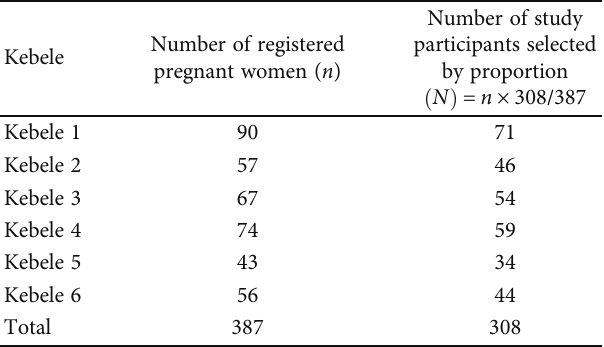
Table 1: The total number of pregnant women and study participants in kebele of Debre Tabor town, Northwest Ethiopia,